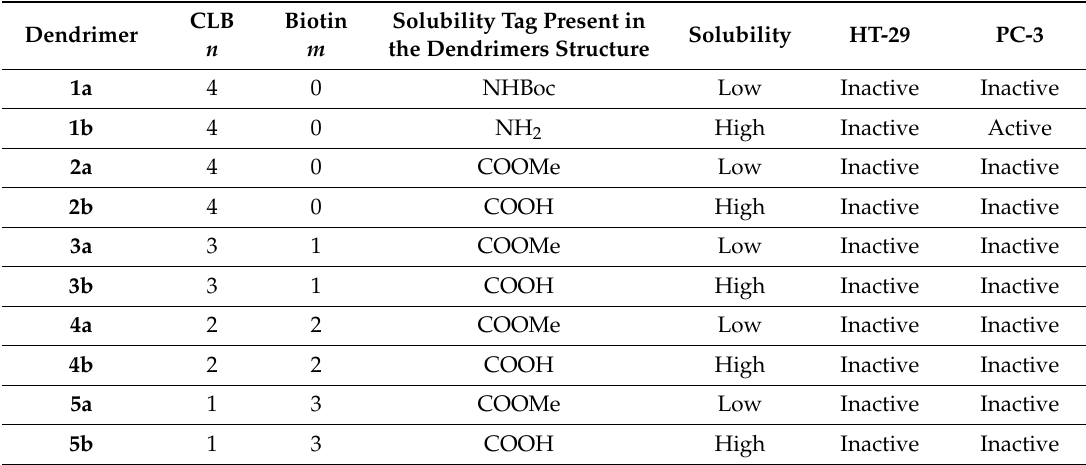
Table 1. List of all synthesized dendrimers, including the ratio of chlorambucil ( n ) and biotin ( m ) per dendrimer molecule, solubility (at 20 mg/mL), and overview of anticancer activity (at ≤ 10 µ M) against HT-29 colon and PC-3 prostate cancer cell lines.